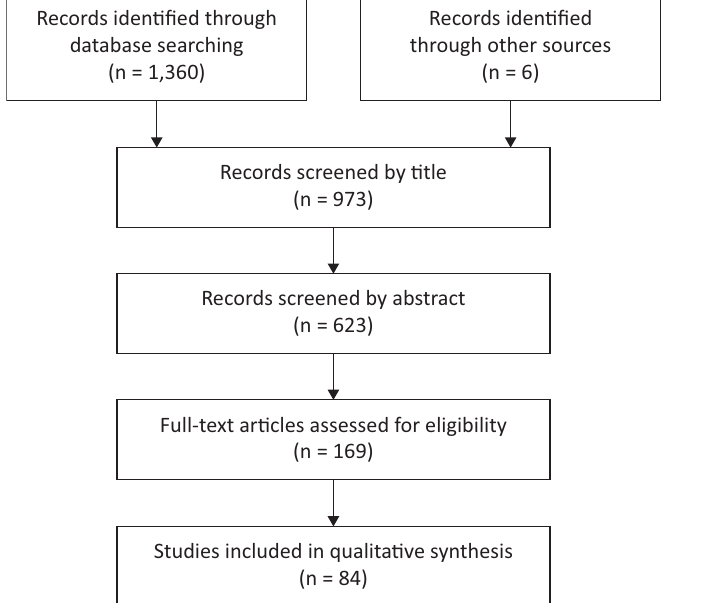
Figure 1. Flowchart diagram of the systematic